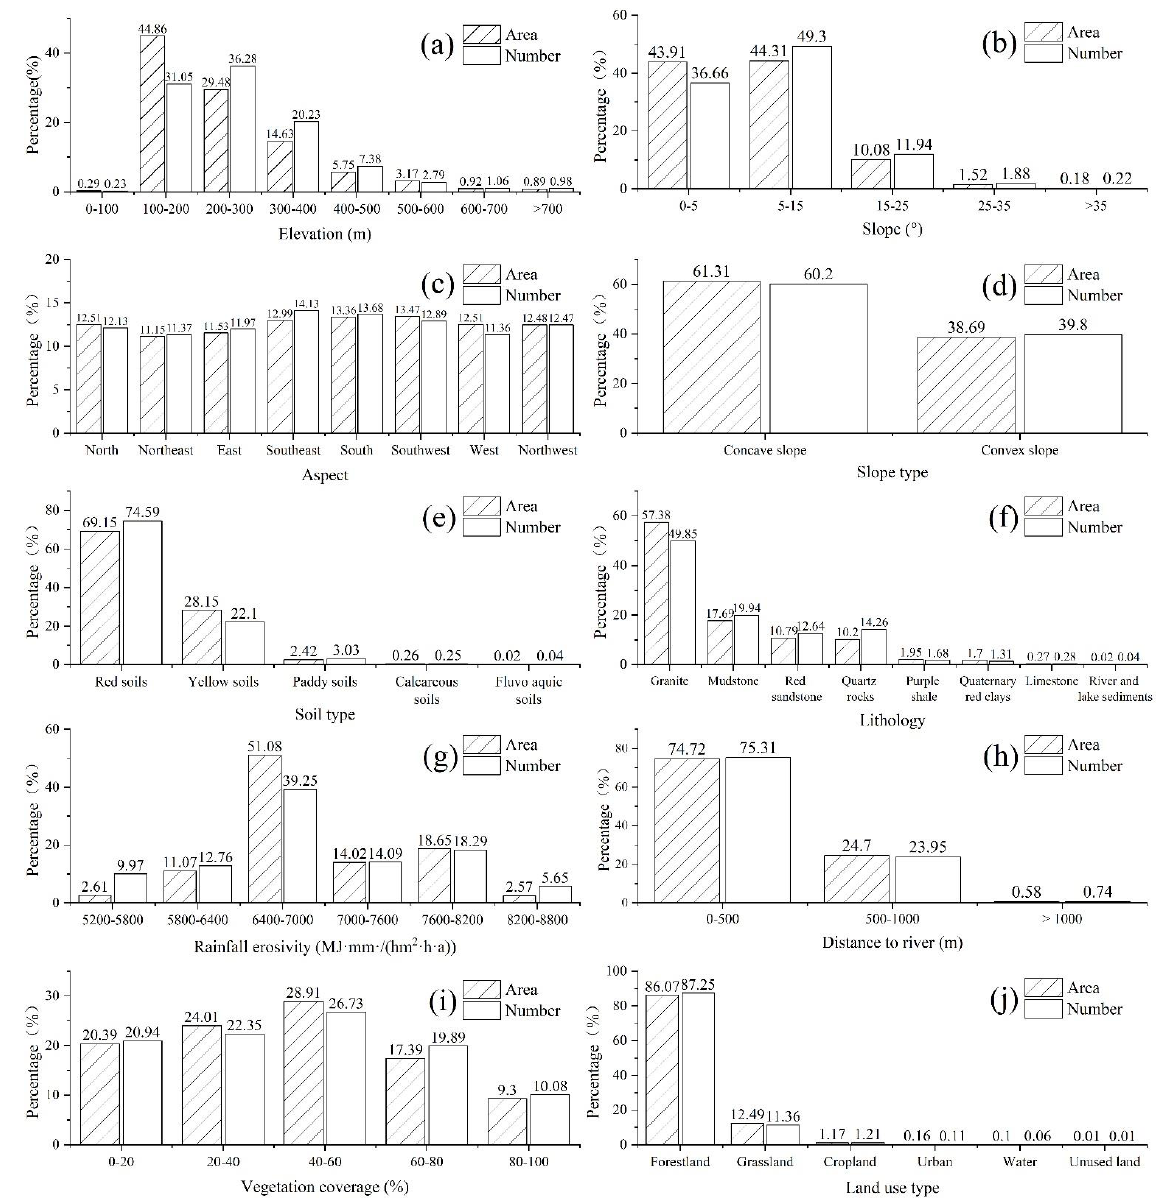
Figure 5. The number and area of Benggang under each influence factor. ( a ) elevation; ( b ) slope; ( c ) aspect; ( d ) slope type; ( e ) soil type; ( f ) lithology; ( g ) rainfall erosivity; ( h ) distance to river; ( i ) vegetation coverage; ( j ) land use type.